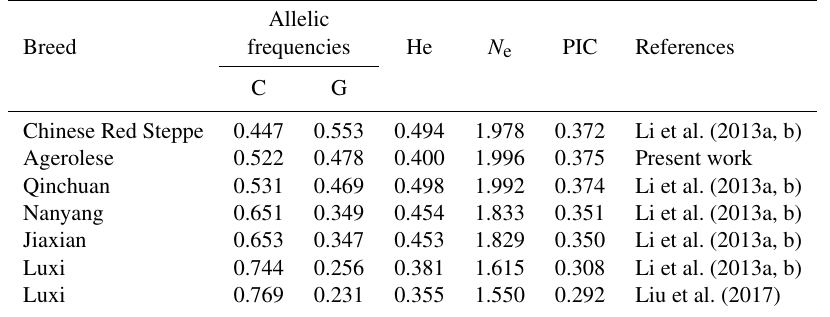
Table 2. Frequencies of C and G alleles and population genetic indices in Agerolese and in different cattle breeds as observed by other authors. Allele frequencies are shown in increasing order for the C allele. Allelic Breed frequencies He N e